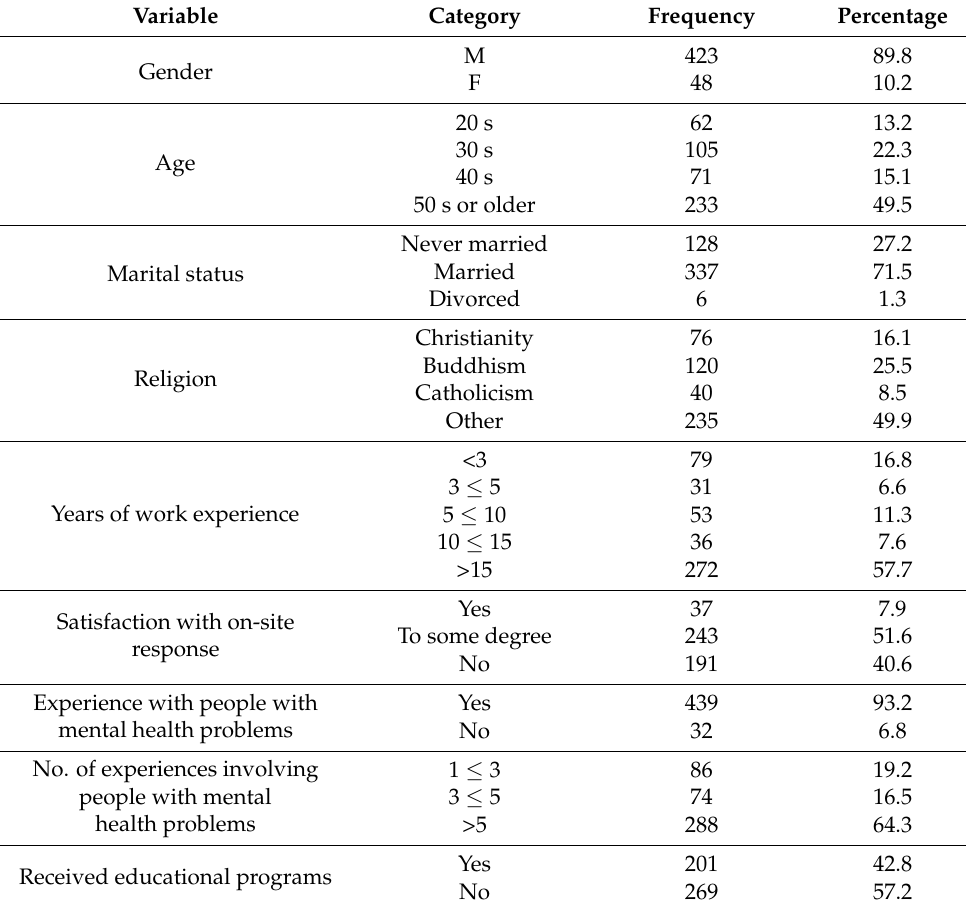
Table 1. General characteristics of the participants (N =